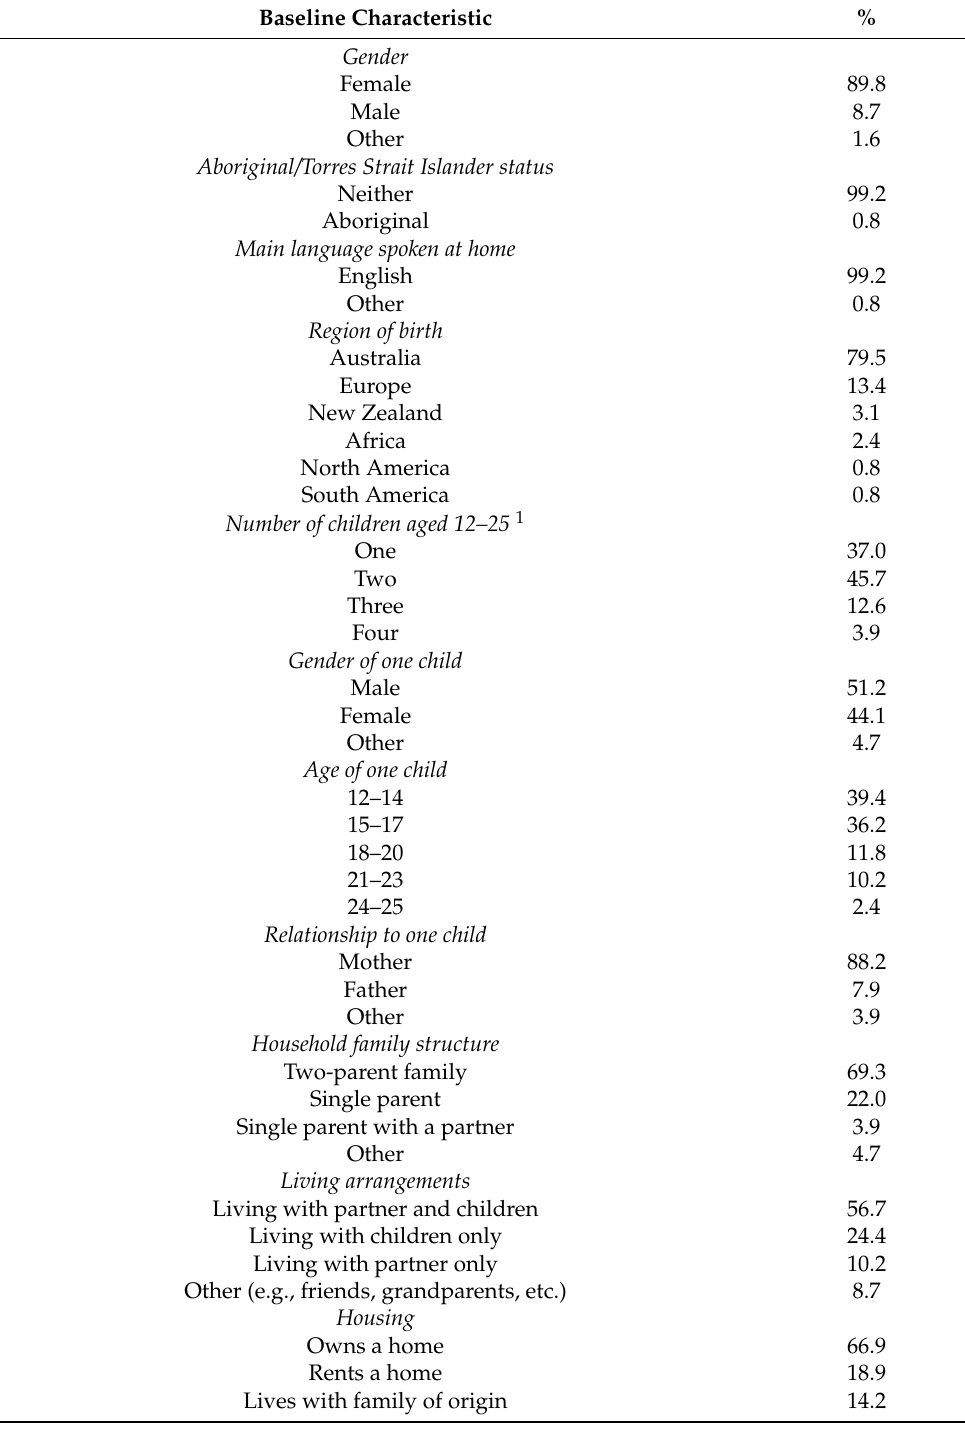
Table A1. Demographic characteristics of the participants at the